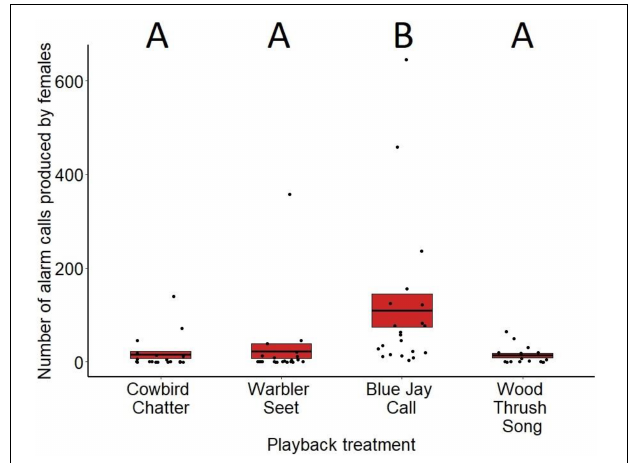
FIGURE 6 | Number of alarm calls produced by female red-winged blackbirds in response to playbacks at nests during nestling stage. Means are shown with the bold line, and shaded boxes represent standard errors. Boxes with different letters denote post hoc statistical differences between treatments. For the p -values of post hoc comparisons, please refer to Supplementary Table 3